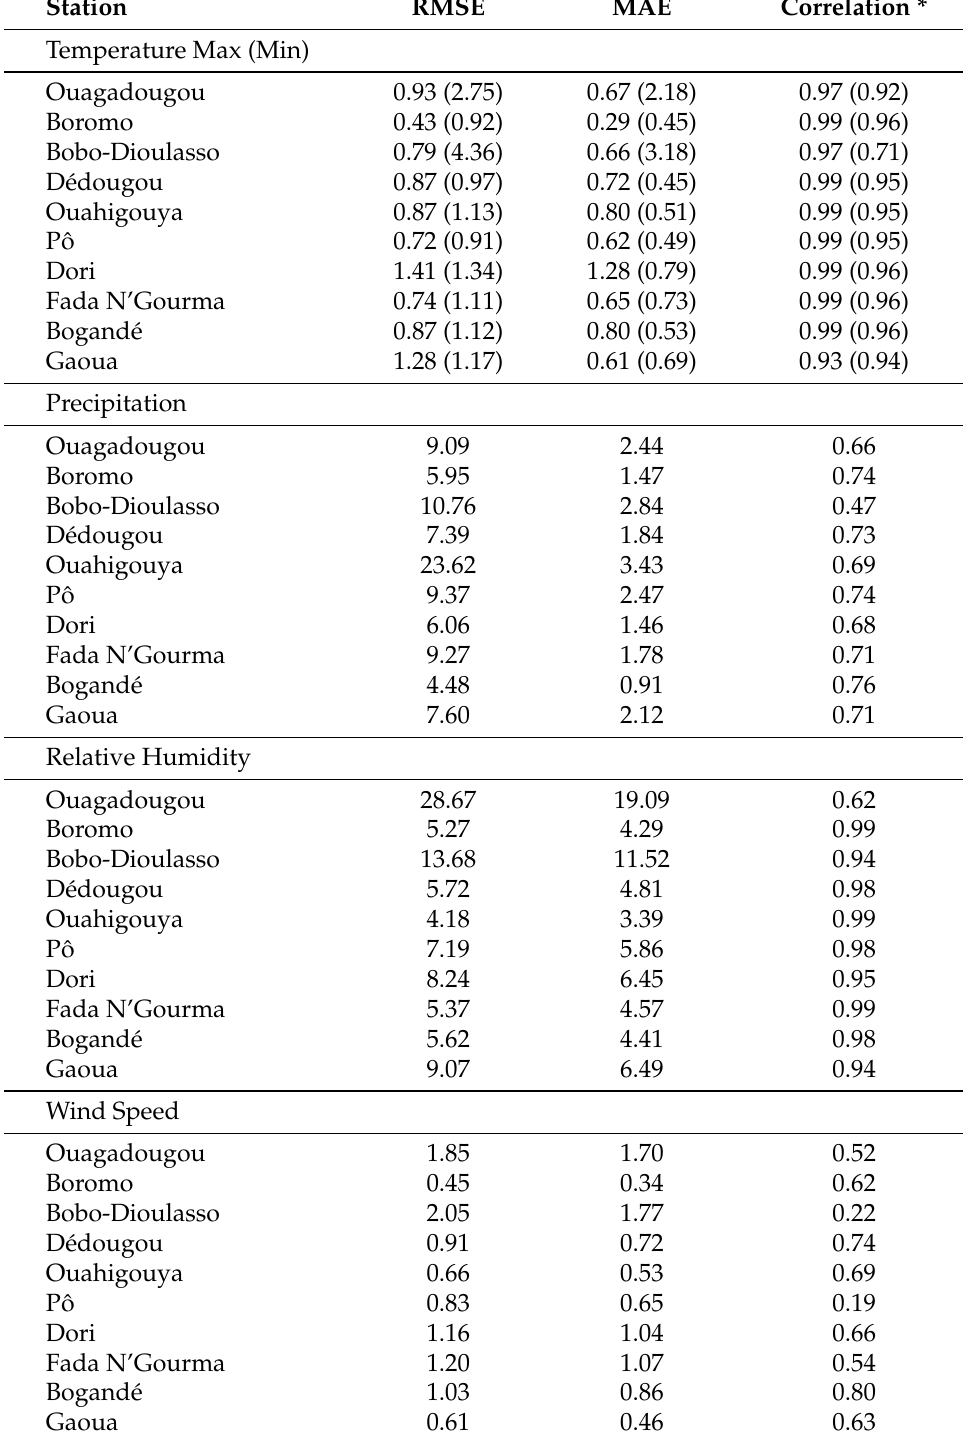
Table 4. Statistical performance measures of all variables between TAHMO and Meteorological Service of Burkina Faso. * The correlation coefficients are tested for statistical significance at α = 0.05, and the null hypothesis (correlation coefficient equals zero) was rejected for all computed values, indicating their statistical